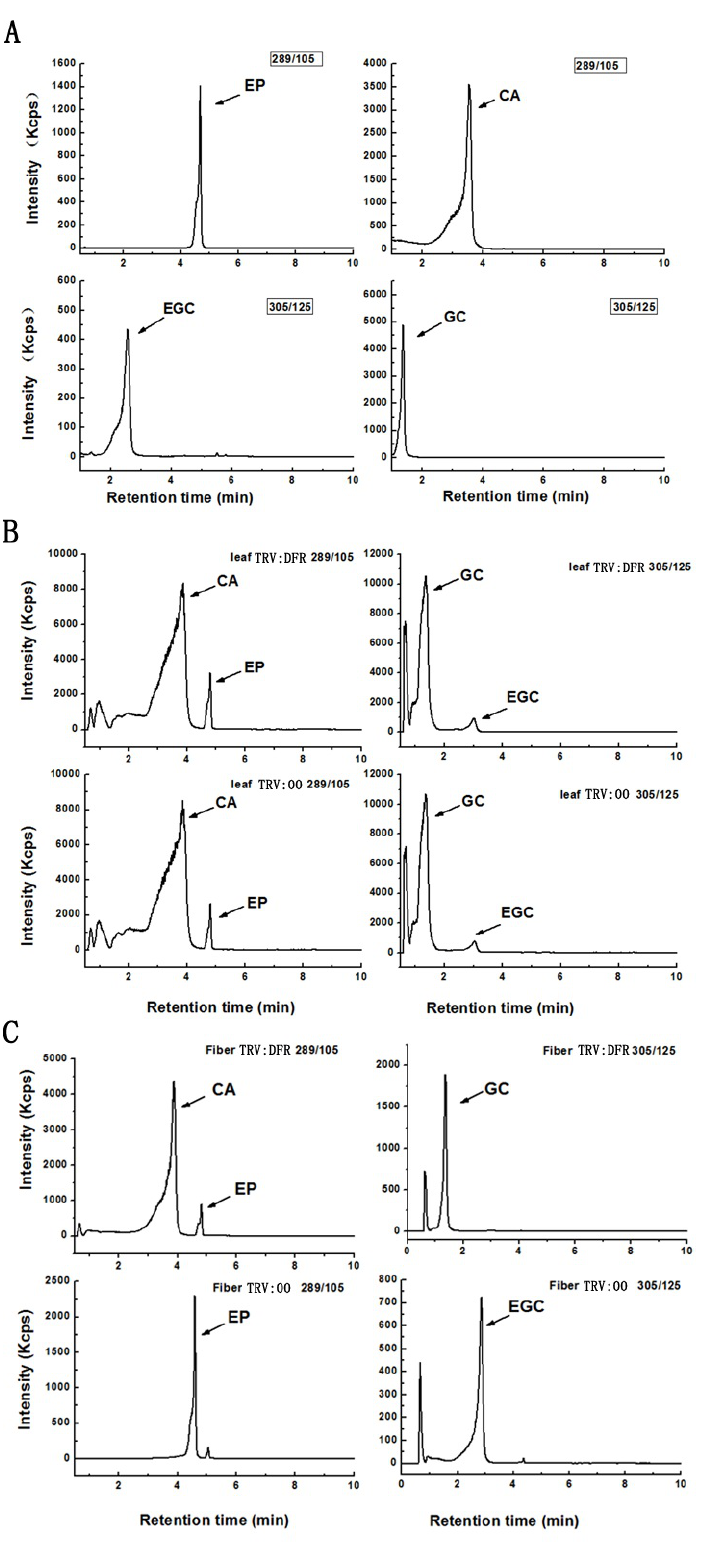
Figure 6. LC-MS-based profiling determines the flavan-3-ols from leaves and fibers of GhDFR1- silenced plants and the control in MRM mode. ( A ) Authentic standards of four flavan-3-ols in in m/z 305 Ñ 125 [M ´ H] ´ transition and m/z 289 Ñ 109 [M ´ H] ´ transition; ( B , C ) flavan-3-ols from leaves ( B ) and fibers ( C ) of GhDFR1 -silenced plants and the control. CA: (–)-catechin; EP: (–)-epicatechin; GC: (–)-gallocatechin; EGC: